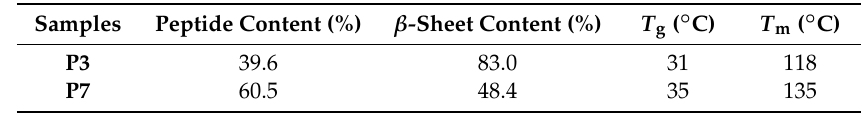
Table 1. Properties of peptidic triblocks.